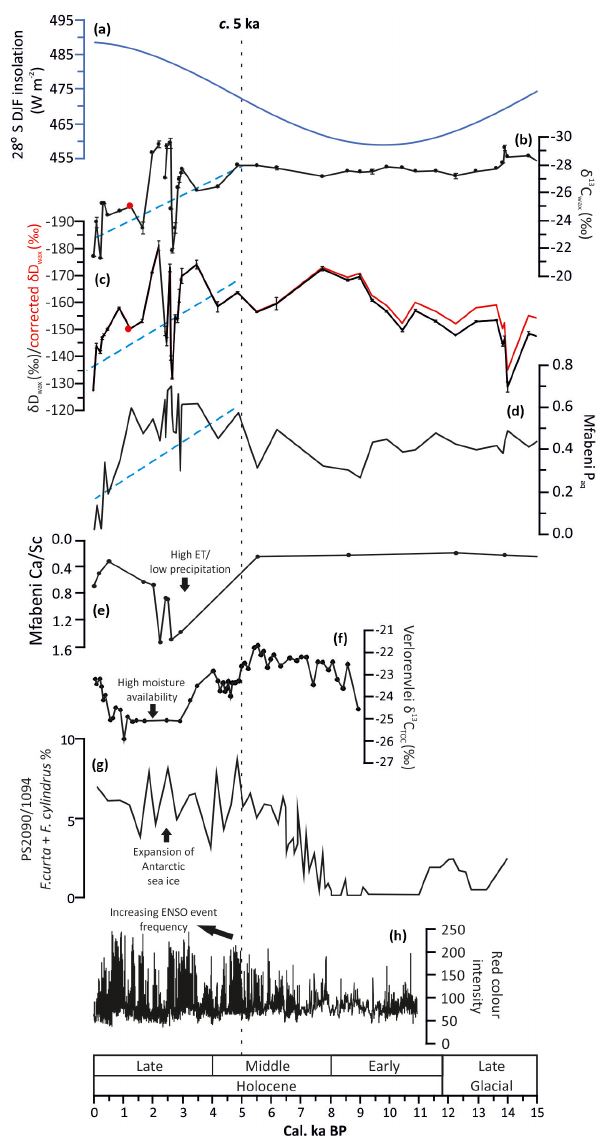
Figure 5. Comparison of Mfabeni data with other records of en- vironmental variability over the last 15calkyrBP. (a) DJF insola- tion for 28 ◦ S (black line; Laskar et al., 2011). (b) Carbon isotope composition (weighted mean) of C 29 –C 31 n -alkanes from Mfabeni, reflecting changes in C 3 / C 4 vegetation type. (c) Hydrogen iso- tope composition (weighted mean) of C 29 –C 31 n -alkanes from Mfabeni, reflecting changes in summer precipitation amount and ET. (d) P aq at Mfabeni, indicating the amount of aquatic vs. terres- trial n -alkanes (high/low water table). Blue dashed lines highlight trends. (e) Mfabeni calcium / scandium ratio, indicating changes in the water table (Humphries et al., 2017). (f) Bulk carbon isotope data from Verlorenvlei (Carr et al., 2015). (g) An estimation of the extent of Antarctic sea ice based on the abundance of Fragilari- opsis curta and Fragilariopsis cylindrus at site PS2090/ODP1094 (south-west of Cape Town; Bianchi and Gersonde, 2004). (h) Red colour intensity time series from Laguna Pallcacocha. High values are light coloured inorganic clastic laminae, which were deposited during ENSO-driven episodes (Moy et al., 2002). The Mfabeni sam- ple with a CPI value of ca. 2 is highlighted in red (b, c) .